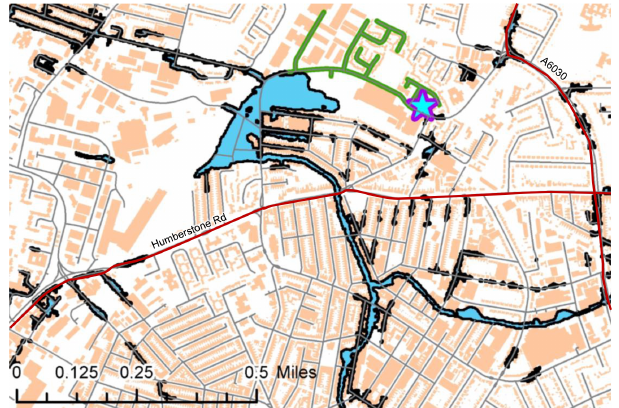
Figure 10. The Southern Fire and Rescue Station during a 1 in 100- year flood event shows that the station is directly at risk of flooding and if sufficient mitigation measures are not taken during a flood of similar or greater magnitude, functioning of the station could be